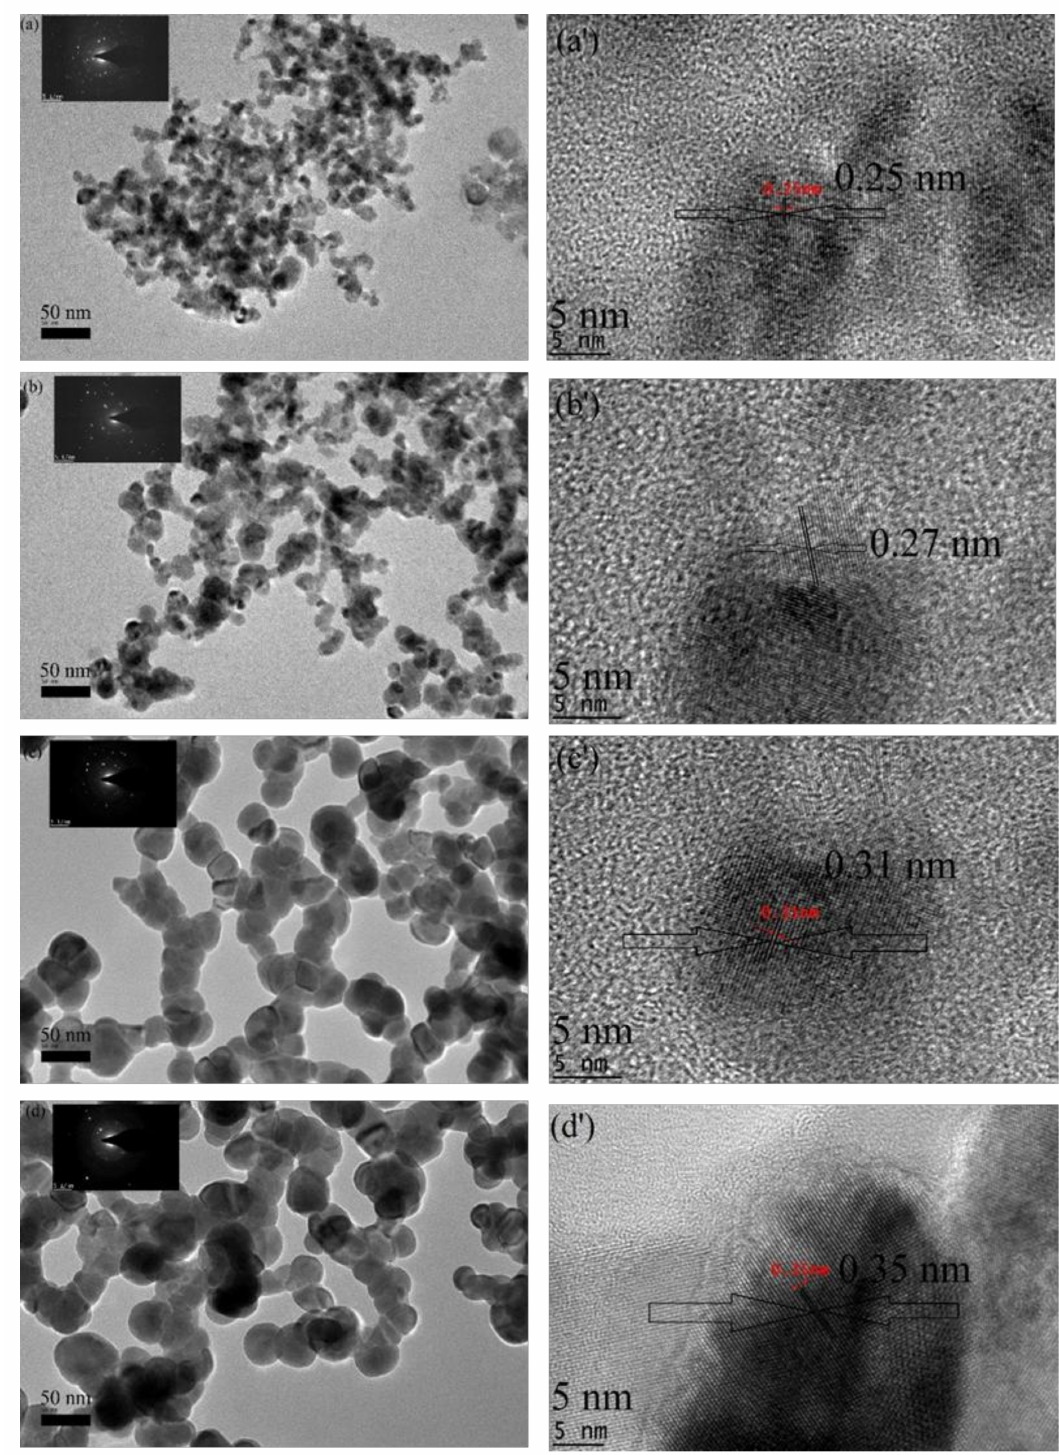
Figure 6. HR-TEM images and the corresponding lattice measurement for willemite NPs produced at 900 ◦ C prepared at different calcination holding times: ( a , a' ) 1 h; ( b , b' ) 2 h ; ( c , c' ) 3 h; and ( d , d' ) 4